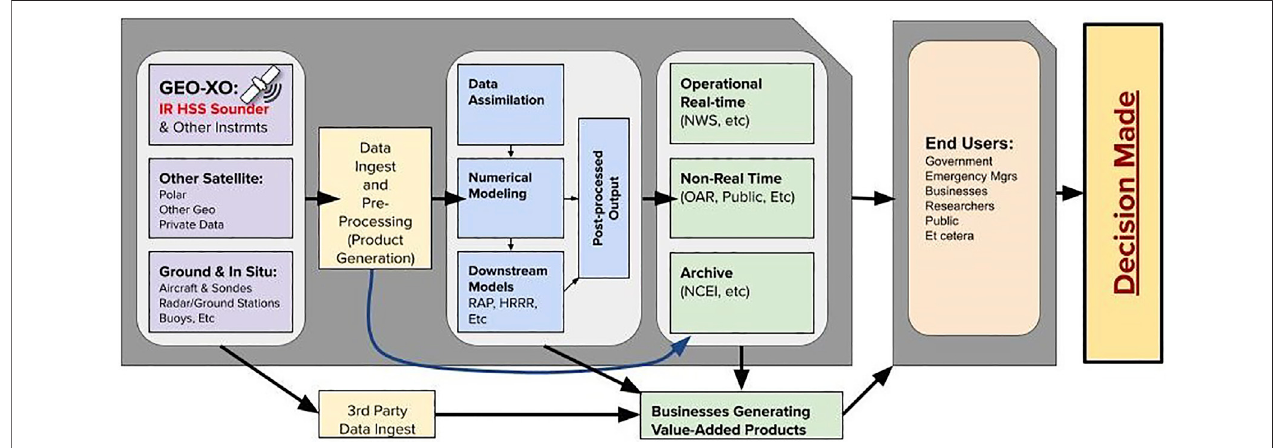
FIGURE 1 | NOAA value chain